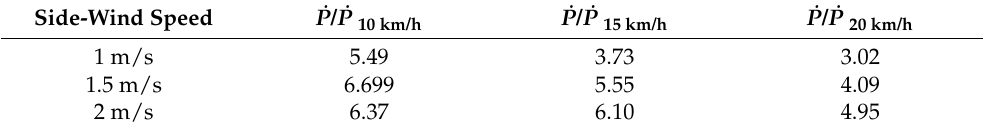
Table 6. Normalised aerodynamic losses at different side-wind speeds at different cruising speeds. Side-Wind